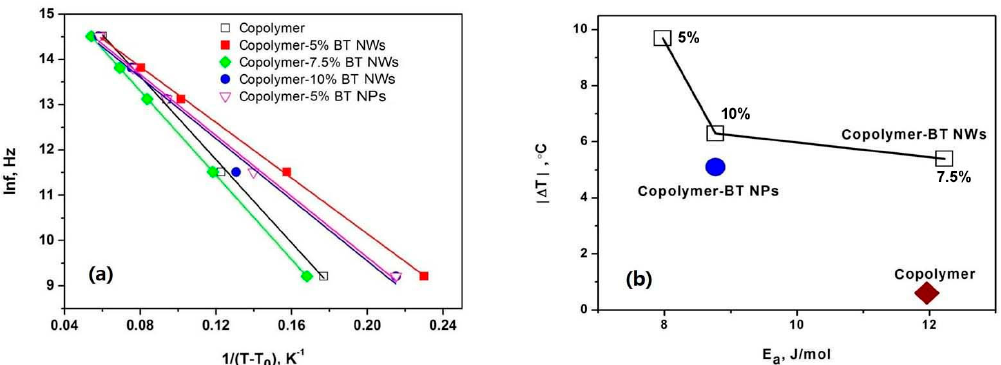
Figure 6. ( a ) Determination of the activation energies of dielectric relaxation in P(VDF–TrFE) and P(VDF–TrFE)–BT nanocomposites. ( b ) The relation between the negative ECE at 56 °C and the activation energy in P(VDF–TrFE) and P(VDF–TrFE)–BT nanocomposites.